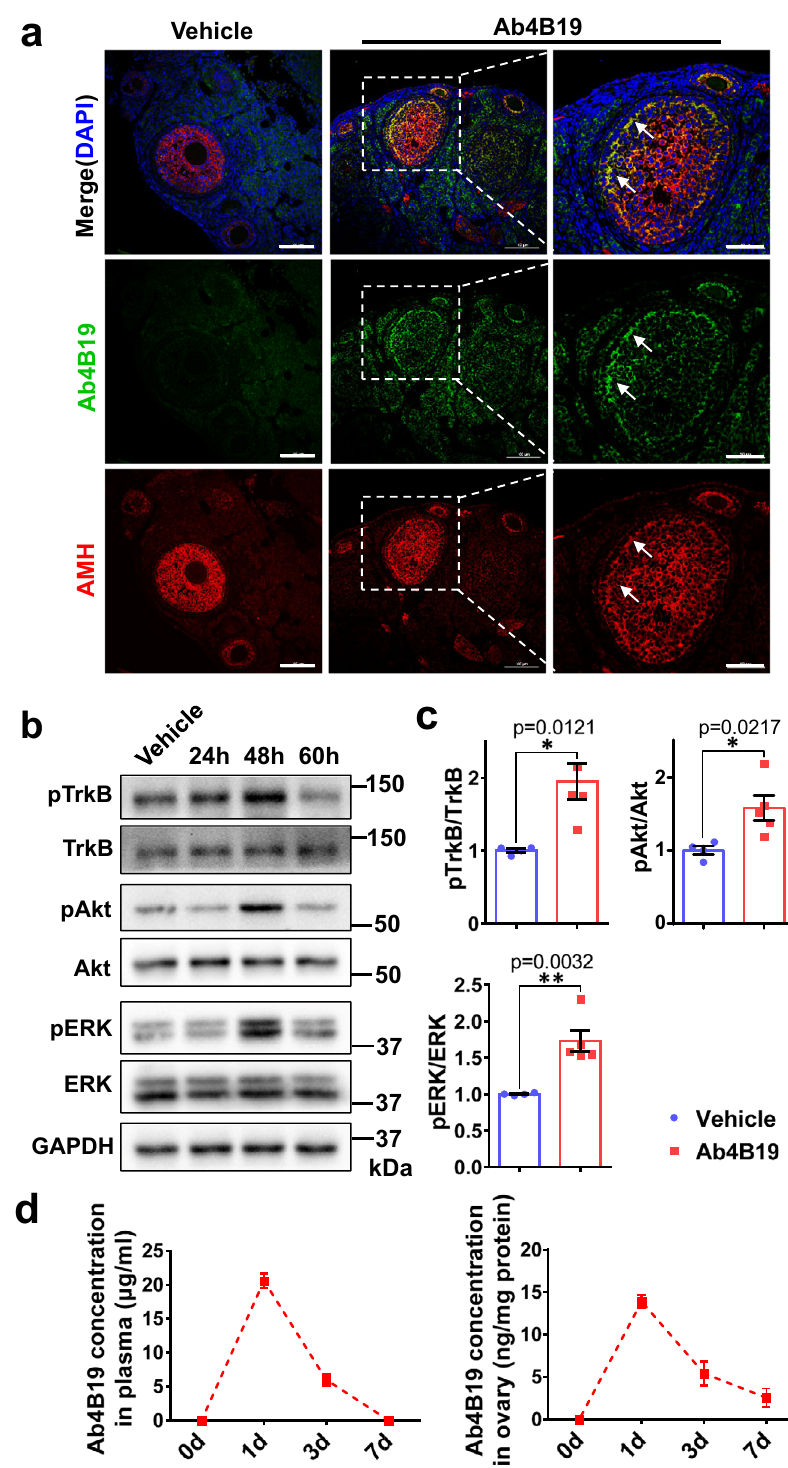
Ab4B19 promoted oocyte maturation and follicle development . BDNF promoted oocyte meiosis in culture, as characterized by germinal vesicle (nuclear envelope) breakdown (GVBD), chro- mosome condensation, and extrusion of the fi rst polar body 20,26 . Our dose-response experiment using cultured oocytes revealed that similar to BDNF (0.2 nM), Ab4B19 (0.2 nM) effectively and this effect could be blocked by the Trk receptor